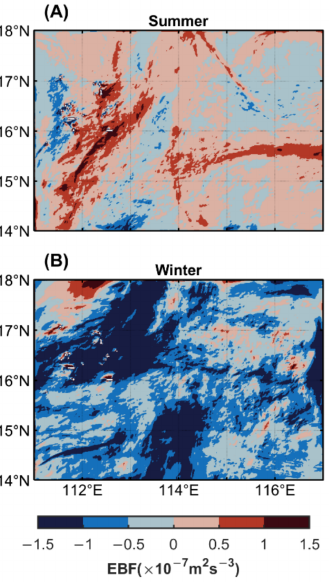
Figure 13. Comparison of the monthly averaged EBF on the sea surface in ( A ) July (( B ) January) from 2017 to 2019, representing summer